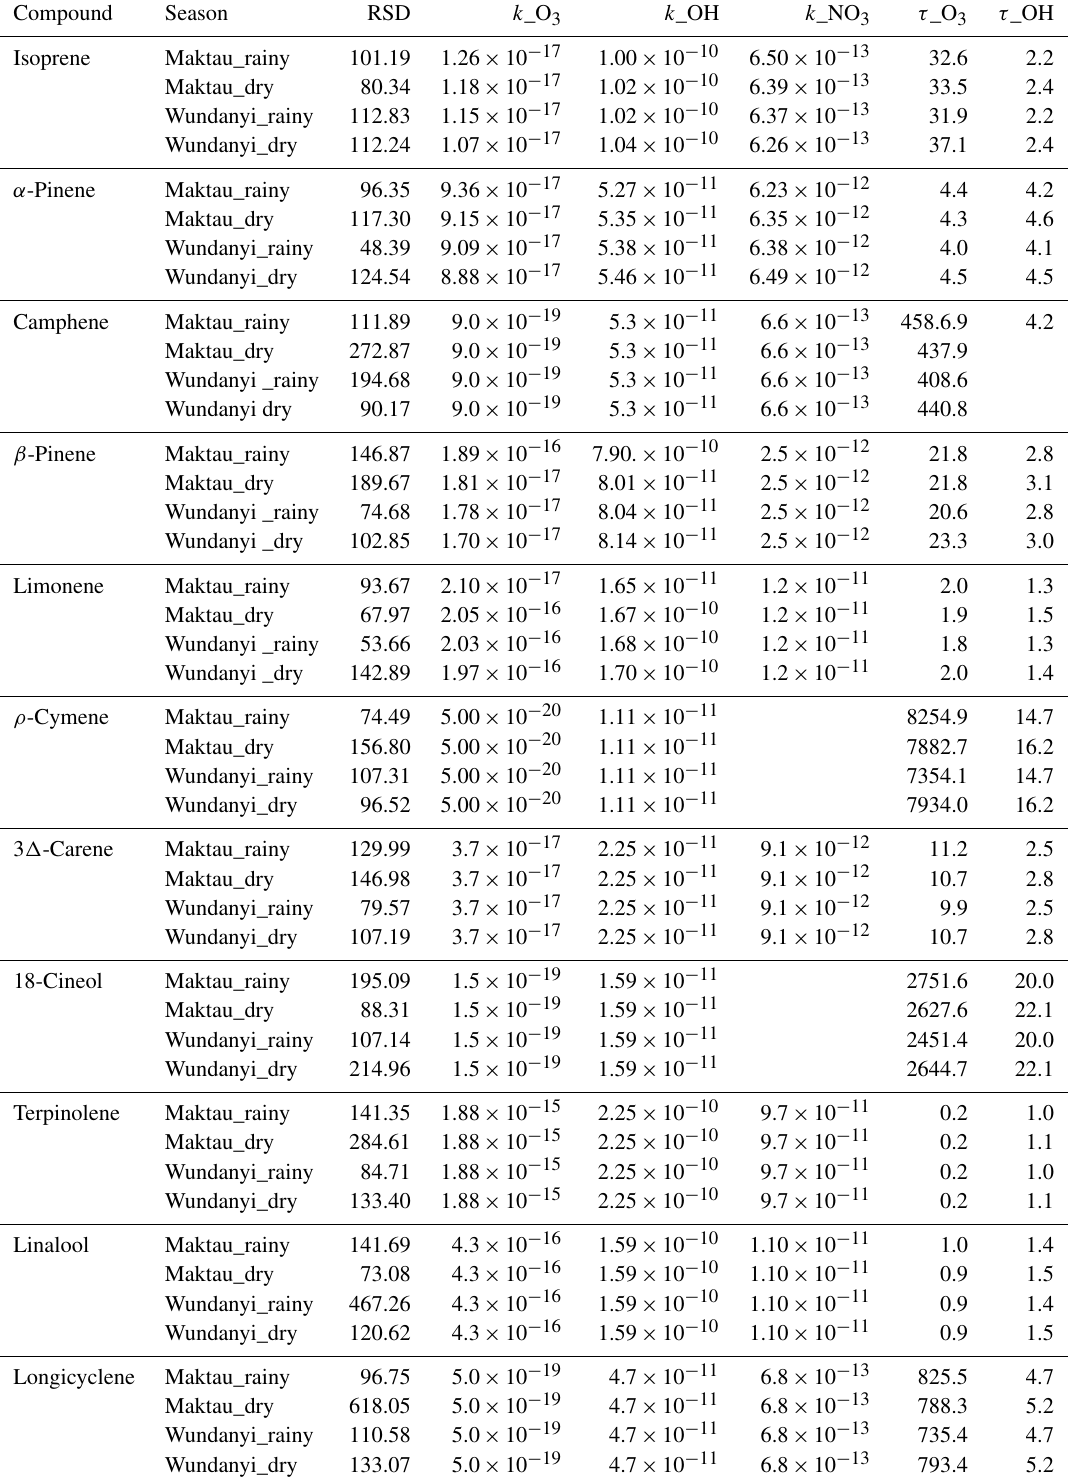
Table A4. Data variation and O 3 , OH, and NO 3 reaction rate coefficients ( k i,x ; values were shown in daily average) for various BVOCs. RSD is relative standard deviation, units are in percent, the k unit is in cubic centimeters per second (cm 3 s − 1 ), and the τ unit is in hours). Compound